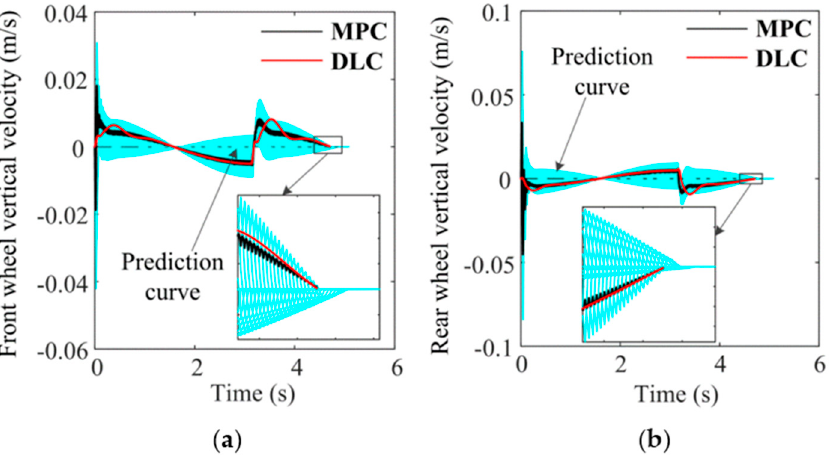
Figure 9. Changes in the vertical velocity of the wheels. ( a ) Vertical velocity of the front wheel; ( b ) Vertical velocity of the rear wheel. ( b ) Vertical velocity of the rear